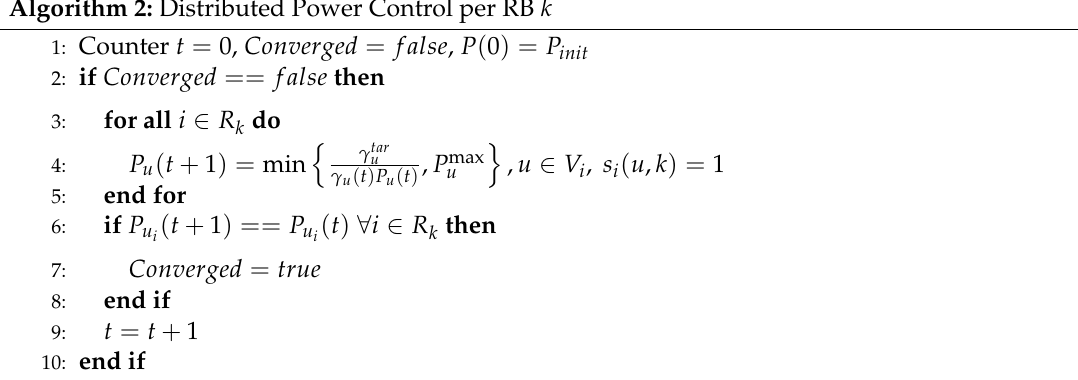
Algorithm 2: Distributed Power Control per RB k